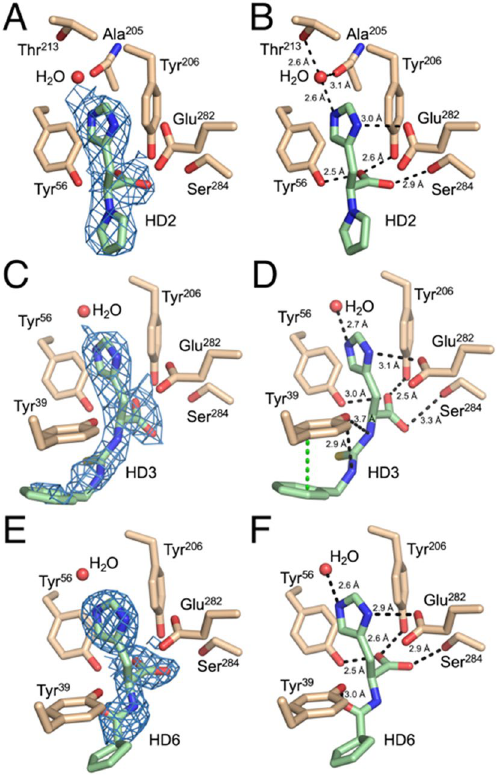
Figure 4. EgtD-HD2, EgtD-HD3 and EgtD-HD6 structures. ( A , C , E ) Composite omit 2Fo–Fc maps (blue) for Histidine/Histamine derivatives contoured to 1.0 σ. ( B , D , F ) Polar and π-π interactions of derivatives with the L-Histidine binding site. The ligands are colored in green (C: green, O: red, N: blue, and S: yellow), and the binding site residues are tan colored (C: tan, O: red, and N: